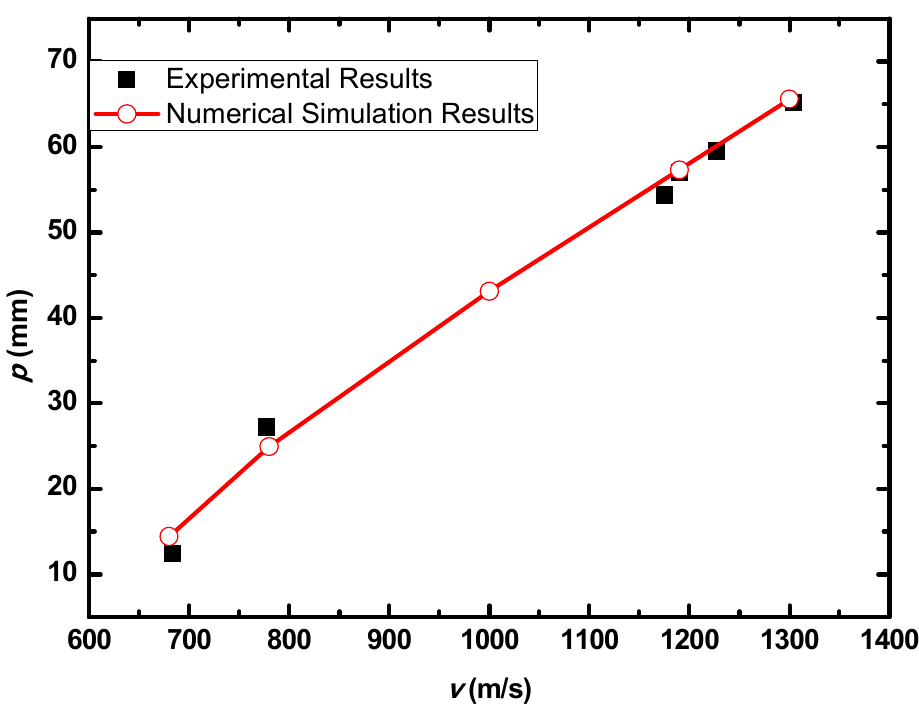
Figure 12. p–v curve of the blunt projectile penetration into the armor with three layers of PE.